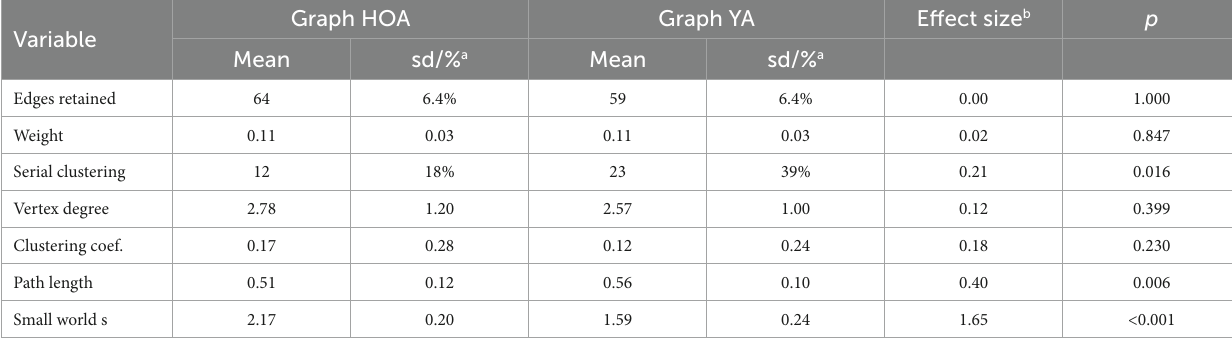
TABLE 3 Mean and standard deviations from major graph